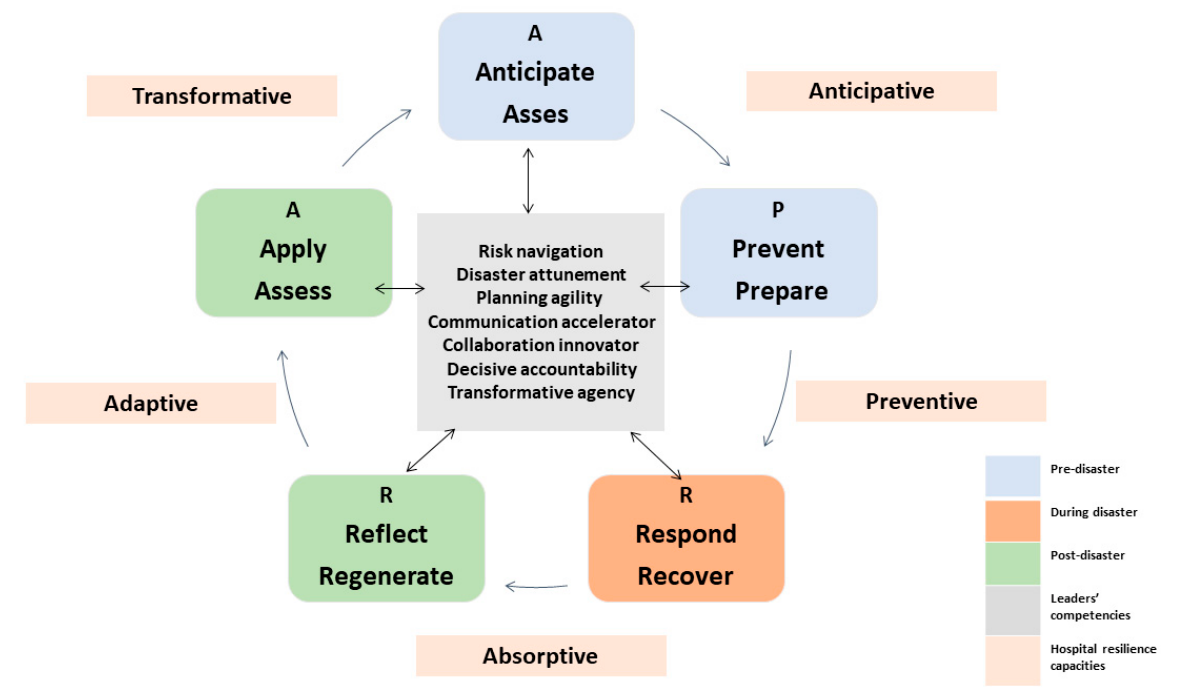
Figure 1. Transformational leadership model for hospital disaster resilience-‘APRRA model’.